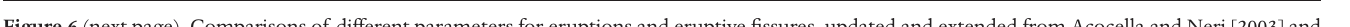
Figure 6 (next page). Comparisons of different parameters for eruptions and eruptive fissures, updated and extended from Acocella and Neri [2003] and Behncke et al. [2005]. (a) Eruption volume versus duration, showing generally higher lava volumes for longer eruptions, although there are wide variations, especially for eruptions lasting <1 yr. (b) Fracture field width versus length, indicating that longer fracture fields tend to also be wider. (c) Length of the lava flow-field versus length of the eruptive fissure system, showing that longer fissures produce longer flows. (d) Eruption duration versus mean eruption rate, where it is clear that shorter eruptions have higher mean eruption rates. (e) Eruptive fracture length versus altitude, indicating that fissures tend to be longer on the lower flanks. (f) Mean eruption rate versus elevation of the lowest vents, showing that eruption rates tend to be higher from low-lying vents and fissures. (g) Length of eruptive fissure systems versus eruption rates, where a broadly positive correlation is evident. (h) Eruptive fissure propagation speed versus total erupted volume, indicating that larger volumes are produced from fast-propagating fissure systems. (i) Maximum length of the lava flow-field versus total erupted volume, showing that in most cases longer lava flow-fields are also more voluminous. (j) Lava flow-field area versus total volume are clearly positively